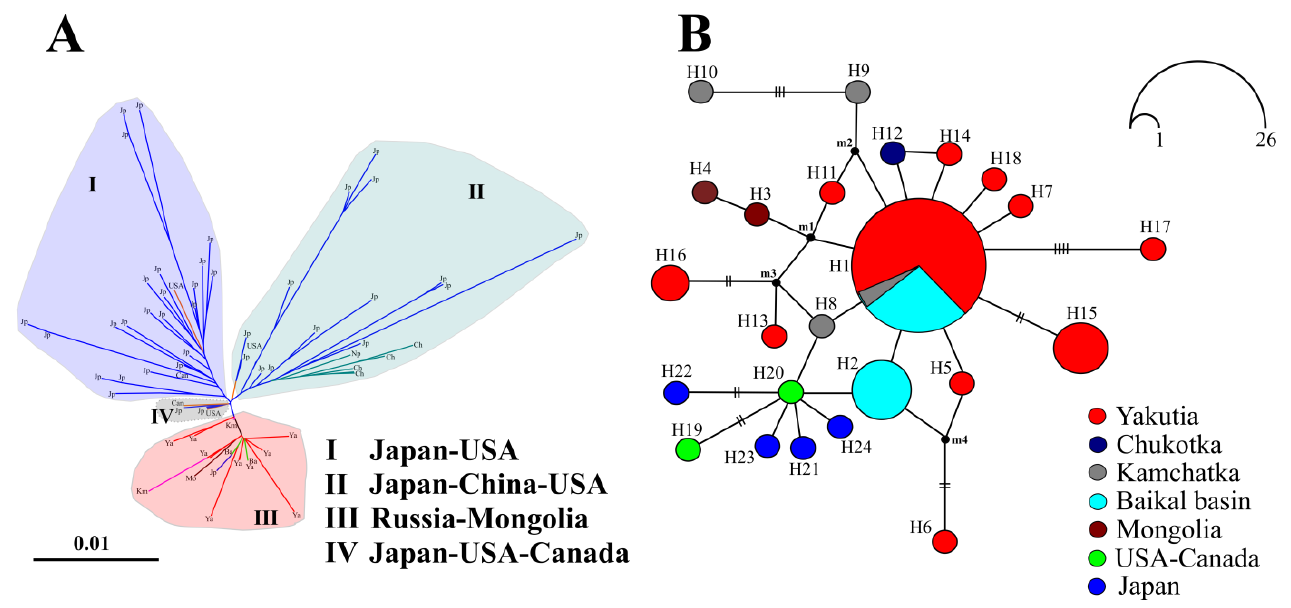
Figure 4. Phylogenetic tree for Daphnia dentifera reconstructed based on original and obtained from the GenBank database 12S haplotypes ( A ) and median-joining network for the clades III and IV ( B ). The scale is given in expected substitutions per site.